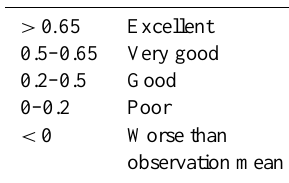
Fig. 2. The North Sea – Baltic Sea transition zone with model bathymetry. Monitoring stations used in the model assessment are indicated with black dots and the two cross sections with black lines. Table 2. MEF performance